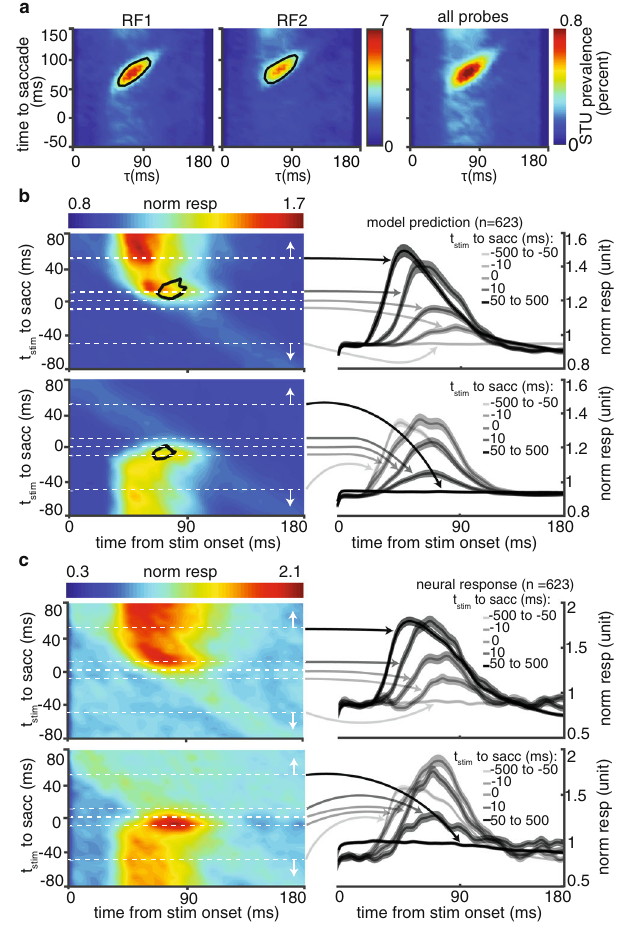
Fig. 3 Identifying the neural basis for an integrated representation of visual space. a Temporal characteristics of integration-relevant STUs. Contours represent the times where the prevalence of integration-relevant STUs over the population of 623 neurons is greater than 50% of the maximum prevalence value. b Model-predicted response of the population across time to saccade and delay. The black contours in ( a , b ) indicate the response components driven by integration-relevant STUs (the same contours aligned to different times). Line traces on the right show the average population model-predicted fi ring rate (mean±SEM), at fi ve sample times relative to the saccade (dashed white lines on the left). c Plots are as in ( b ), but with actual neuronal responses. Line traces on the right represent the population peristimulus time histogram (PSTH) at sample time